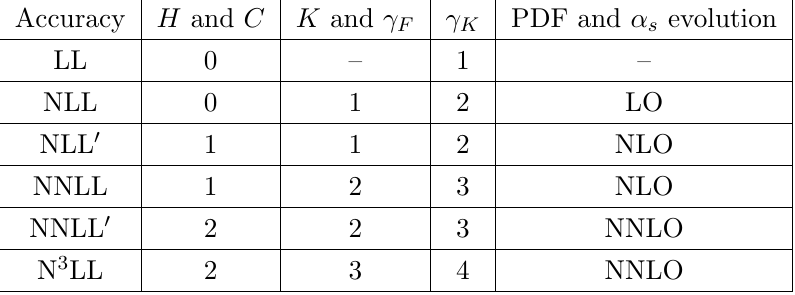
Table 1 . Truncation order in the expansions of eqs. (2.20){(2.22) for the two logarithmic countings considered in this paper (see text). The last column reports the order used for the evolution of the collinear PDFs and (cid:11) s